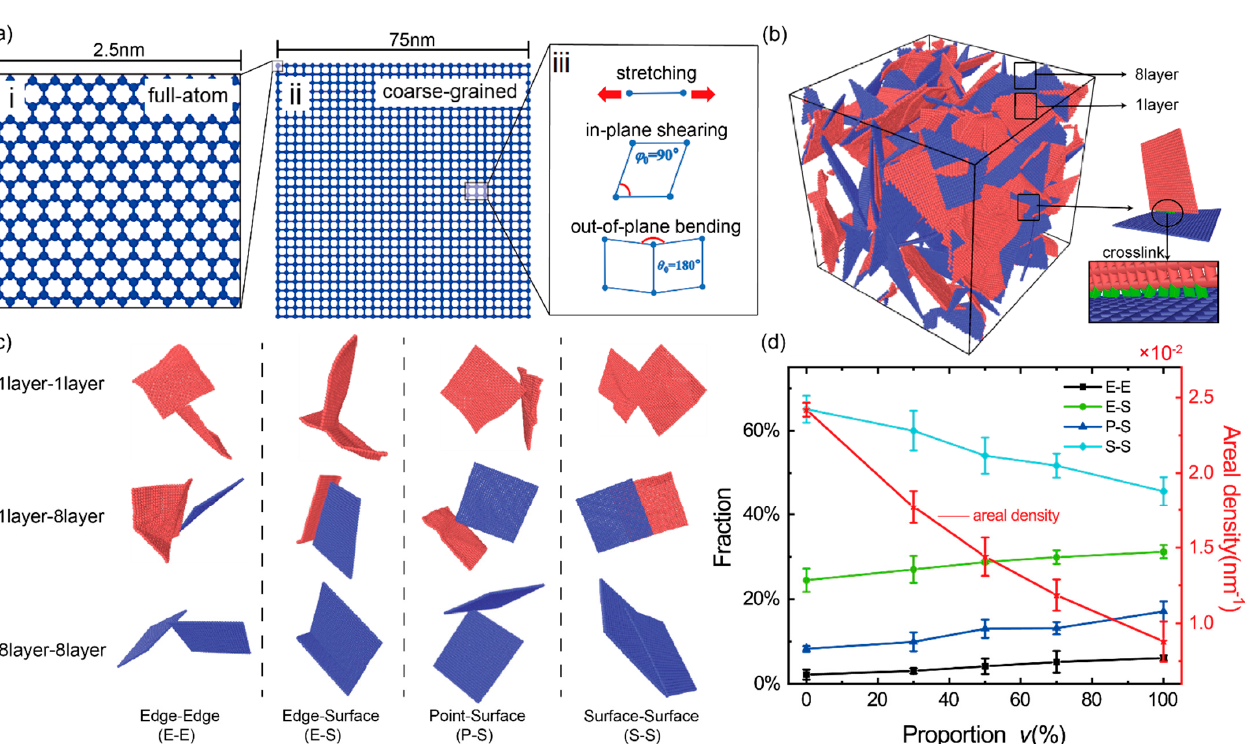
Figure 1. Coarse-grained model of bi-modal GrFs. ( a-i ) A square full-atomic graphene sheet with a side length of 2.5 nm; ( a-ii ) A square coarse-grained graphene sheet with a side length of 75 nm; ( a-iii ) three deformation modes of stretching, in-plane shearing and out-of-plane bending of graphene sheet; ( b ) The initial state of a well-equilibrated coarse-grained GrF consisting of the same number of 1-layer flexible (red) and 8-layer stiff (blue) coarse-grained graphene sheets; The crosslinks (green) are added between neighbor beads in different sheets. ( c ) Four typical microstructures of edge–edge (E– E), edge–surface (E–S), point–surface (P–S) and surface–surface (S–S) for two 1-layer sheets, a 1-layer sheet and a 8-layer sheet, and two 8-layer sheets; ( d ) The fraction of the four typical microstructures and the areal density (the contact area between sheets per unit volume) as an increased proportion of stiff sheets (the number of stiff sheets divided by the total number of sheets).